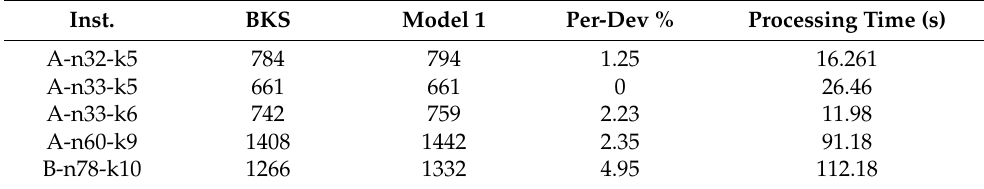
Table 1. VRP results of M 1 .